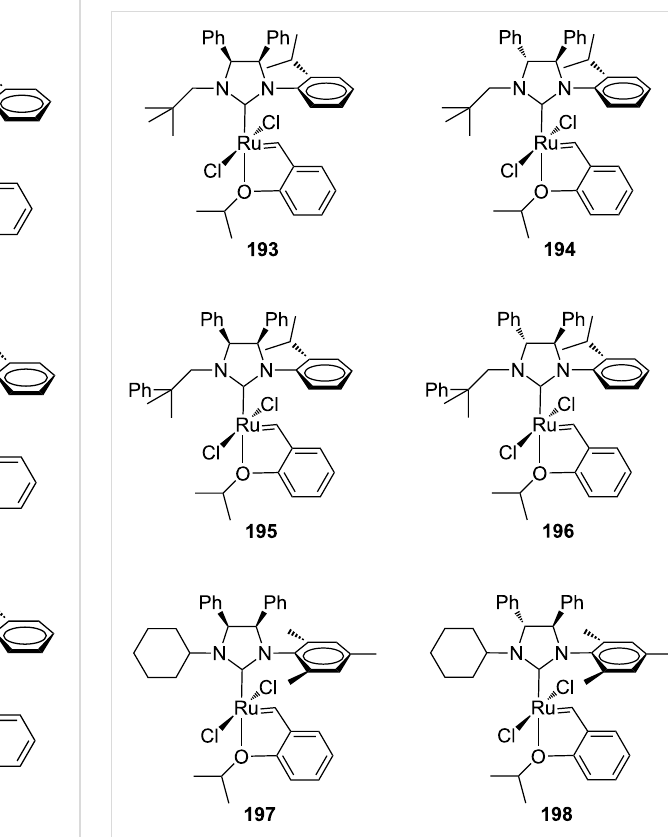
Figure 35: Hoveyda-type complexes 193 – 198 bearing N- alkyl, N’ -aryl backbone-substituted NHC